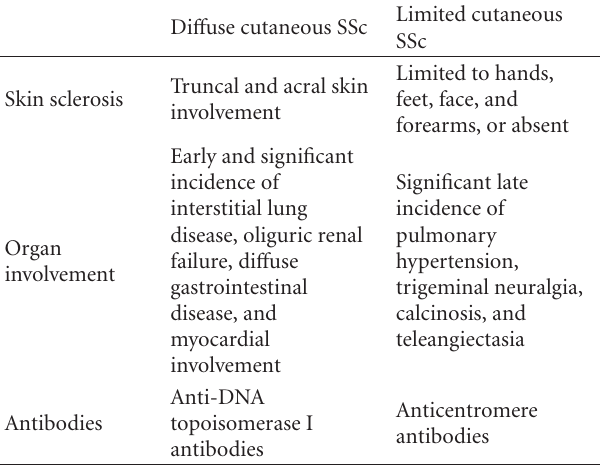
Table 1: SSc subsets and organ